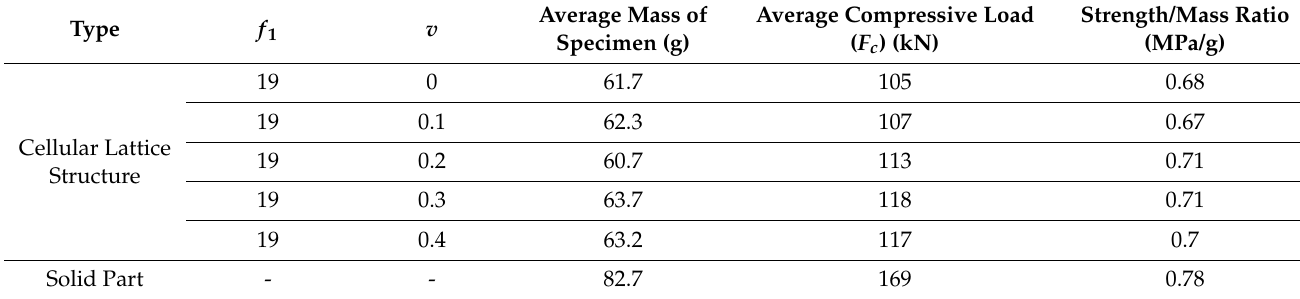
Table 6. First test series results of test specimens with frequency 19 and 100% infill density.